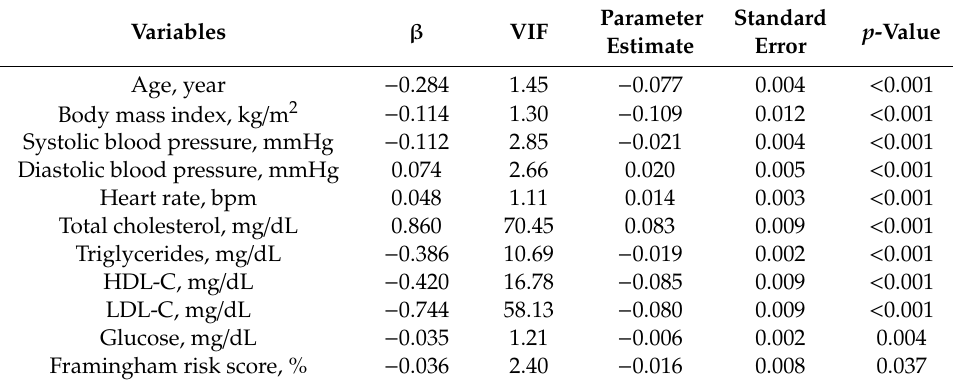
Figure 1. Scatter plot showing the relationship between FMD and LDL-C. Table 2. Multiple linear regression analysis of the relationships between FMD and